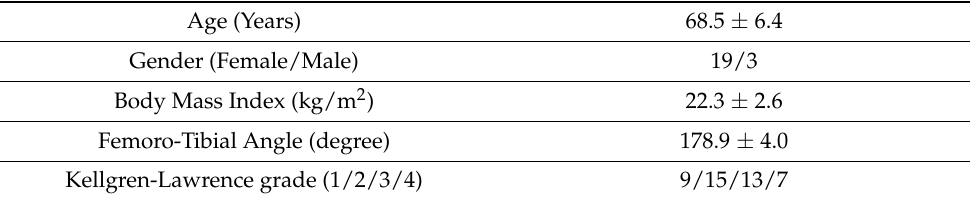
Table 1. Patient demographics (mean ± SD).